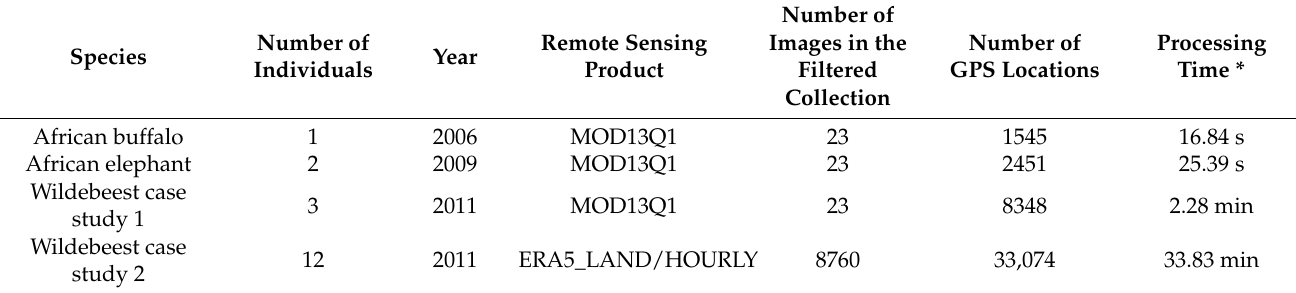
Table 1. Summary of species, telemetry data, remote sensing data product used, and processing time for extracting pixel values to each GPS location. For each GPS location, the closest remote sensing image in time was identified to extract pixel